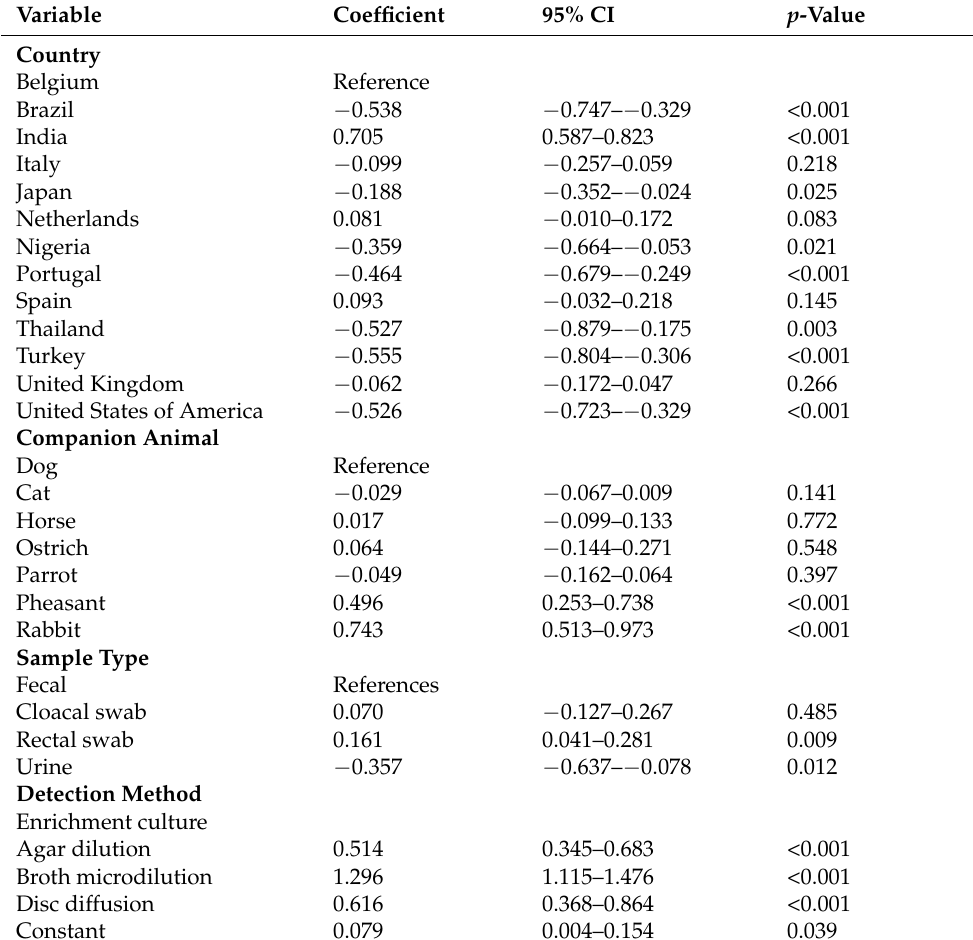
Table 7. Final multivariable meta-regression